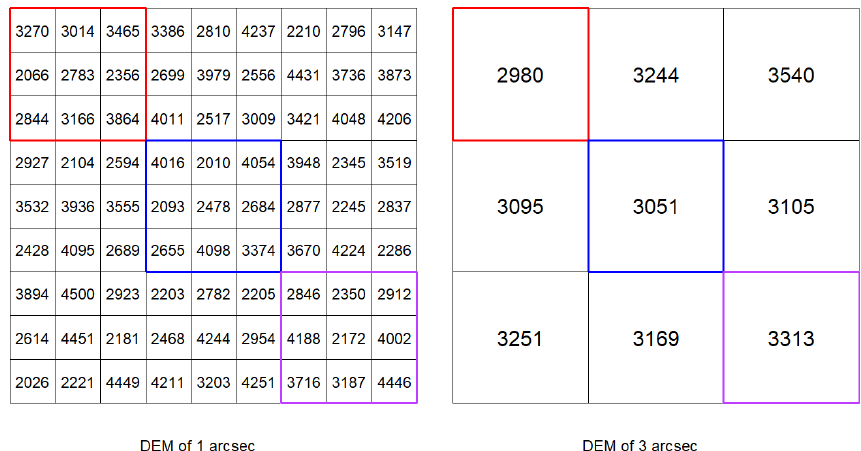
Figure B1. Schematic illustration of DEM aggregation from a grid spacing of 1 to 3arcsec by averaging. Numbers in the pixels are elevations in meters. In the hypsometric simulation, the DEM with a grid spacing of 15arcsec is derived using the same